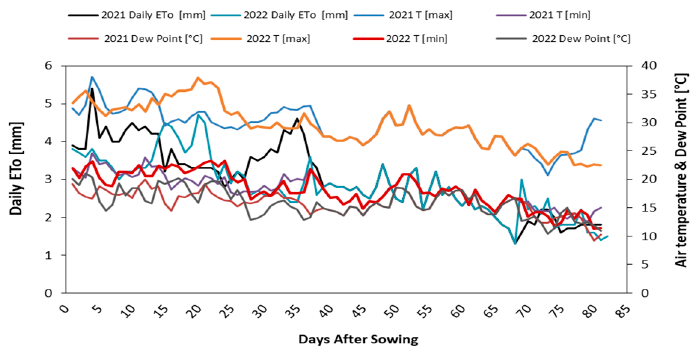
Figure 2. Daily air temperature (T min and max) and reference evapotranspiration ( ET o ) at the experimental site during the two growing seasons (2021 and 2022).